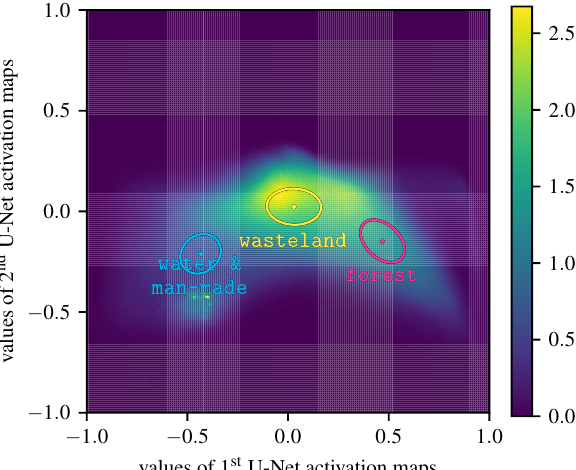
Figure 6. Empirical densities of the two U-Net activation maps aggregated from all samples. The ellipses represent the 1-sigma isolines of the three Gaussian mixture distribution components. The points mark their mean